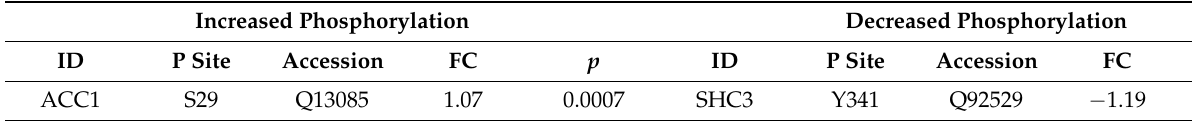
Table 5. Differentially Phosphorylated Peptides in Node in Response to